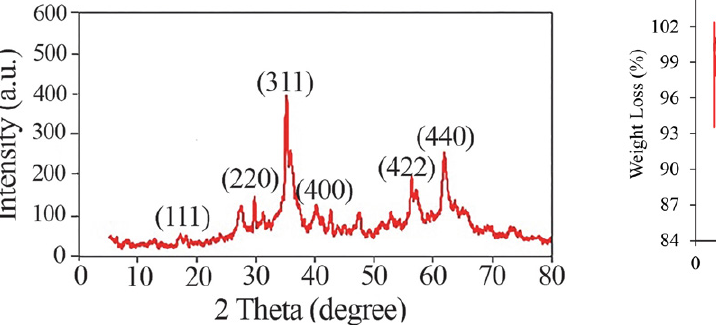
Figure 6. TGA-DTG analysis for thermal stability of MnFe 2 O 4 nan-